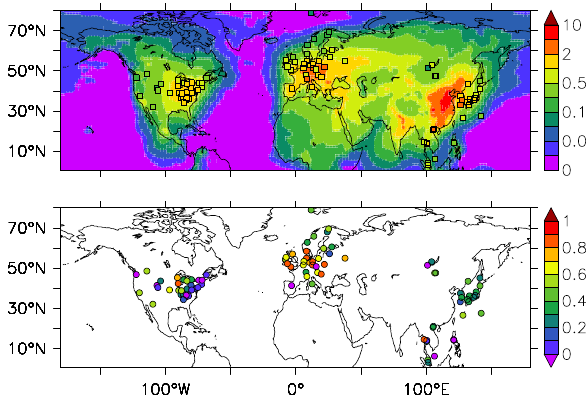
Fig. 9. As Fig. 5 but for NH +